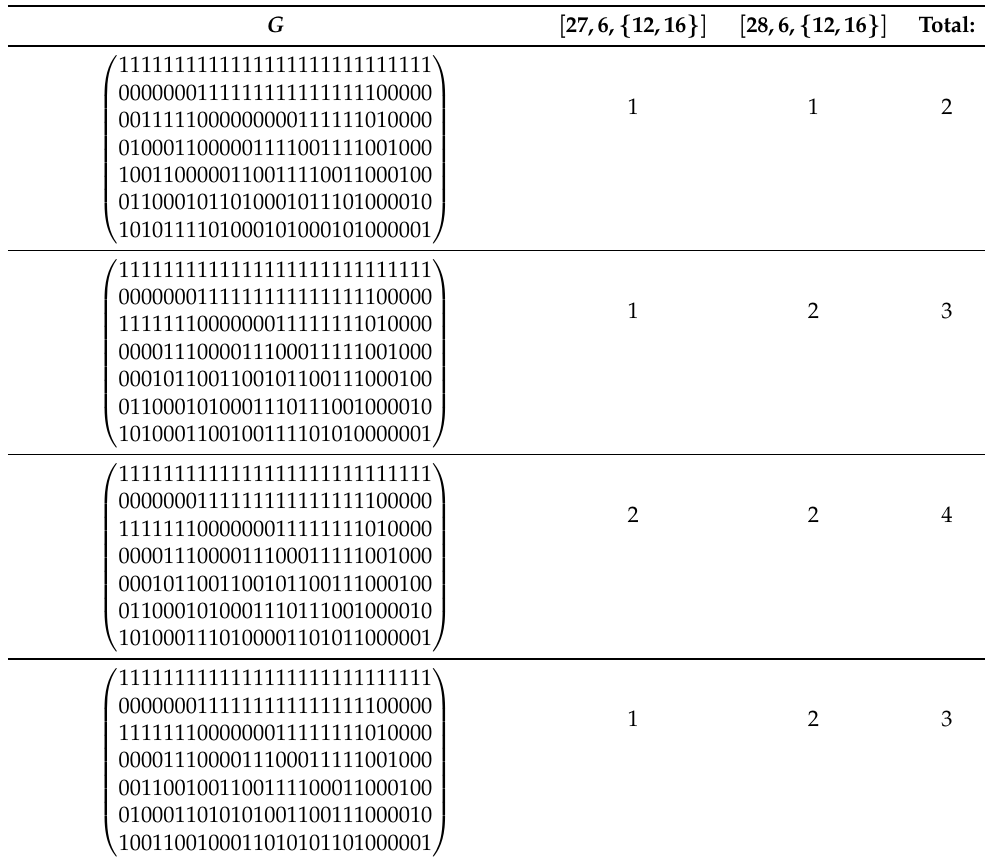
Table 4. Self-complementary [ 28,7, { 12,16,28 } ]